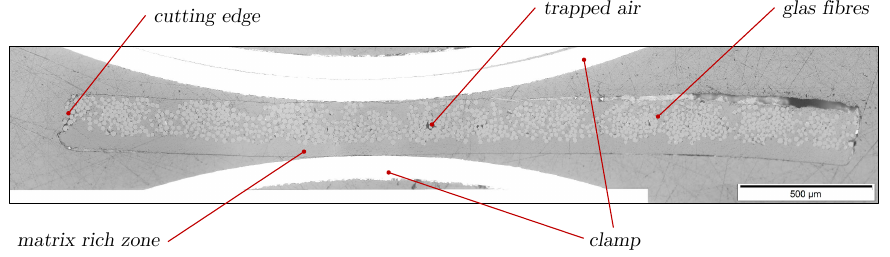
Figure 6. Micrograph of the transversal section of used PP GF 60 prepreg material (magnification of objective 20 × ).